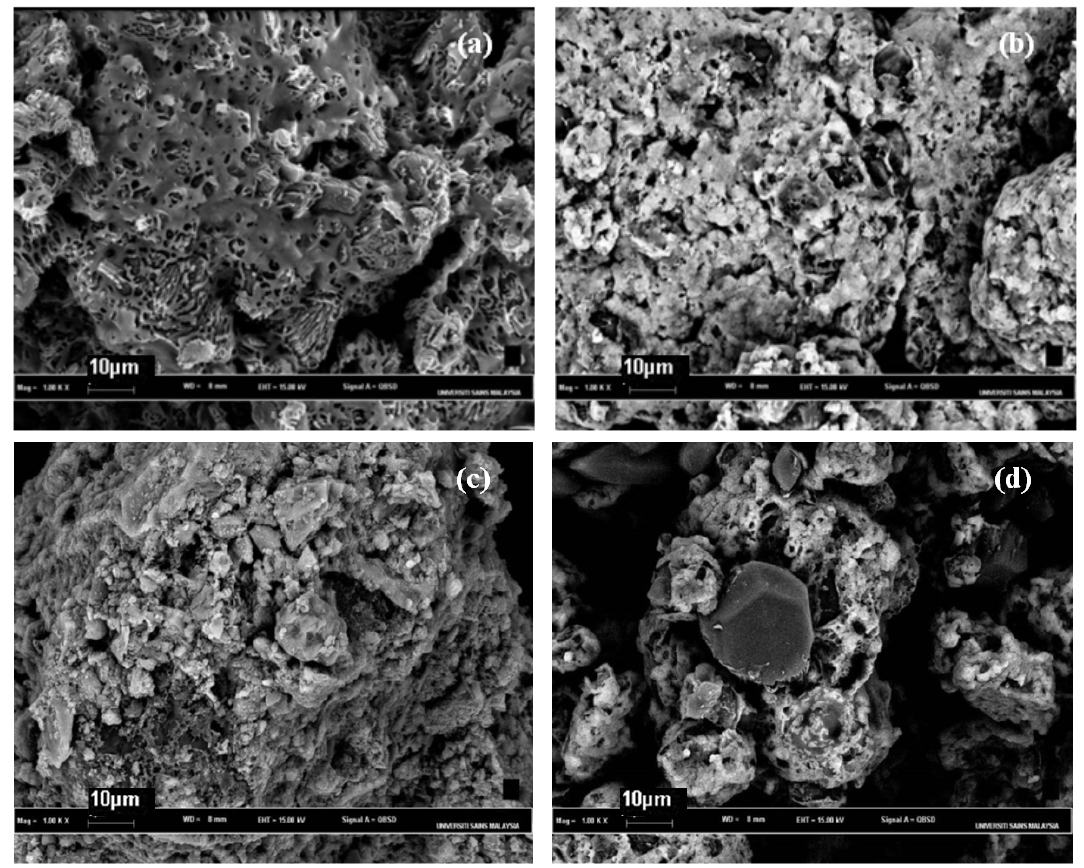
Figure 2. Scanning electron micrographs at 1000× of polymers ( a ) P10; ( b ) P11; ( c ) P151, and ( d ) P15.